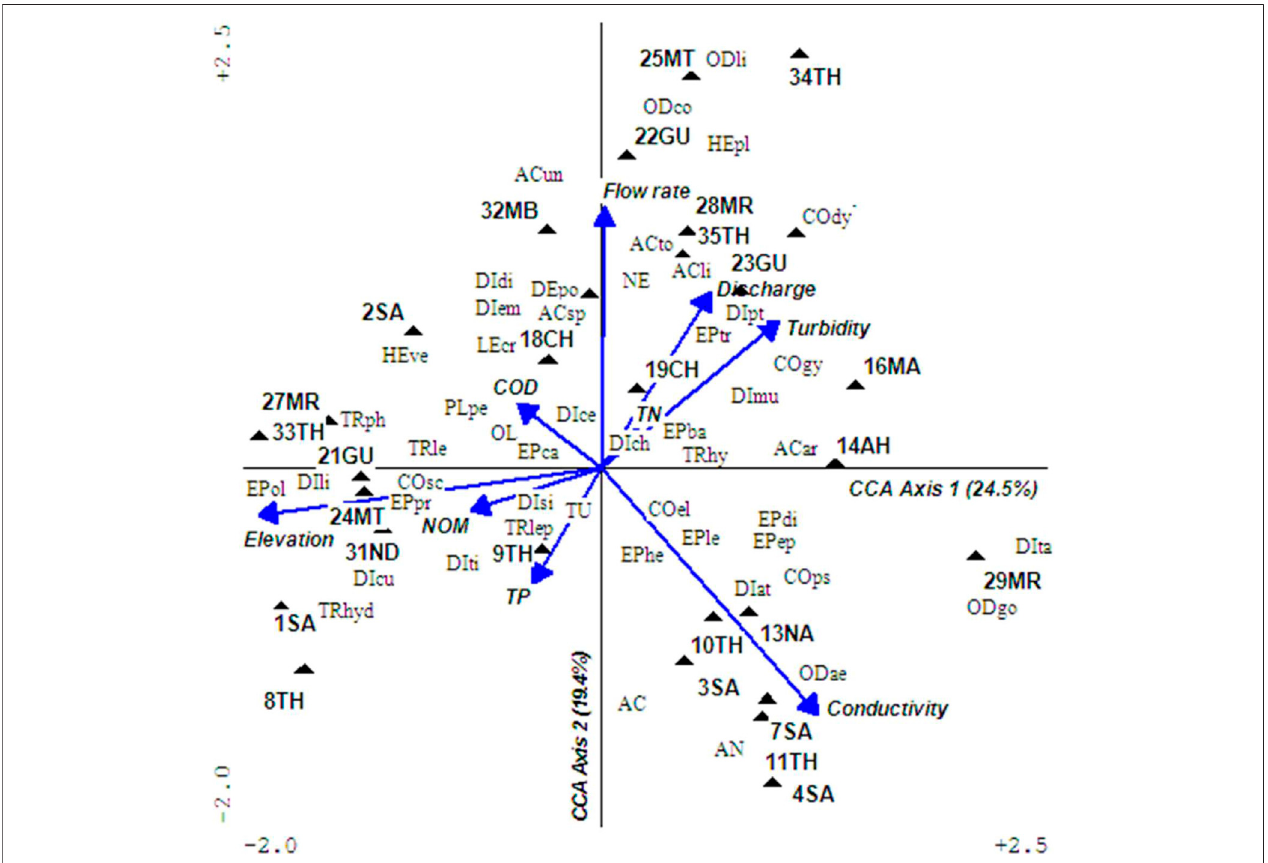
FIGURE 4 | A triplot of macroinvertebrates assemblages and water quality during the dry season. The fi rst four CCA axes explained signi fi cant relationships between macroinvertebrates and water quality ( p (cid:2) 0.05). Arrow represents water quality parameters and fi lled triangle sampling sampled sites. The abbreviated four- letter labels signifymacroinvertebrates ’ taxawiththe fi rsttwo-uppercaseletters standing fororderandthenexttwolowercase lettersforfamily.Fullmacroinvertebrates ’ taxa names are provided as Supplementary Table S2 .